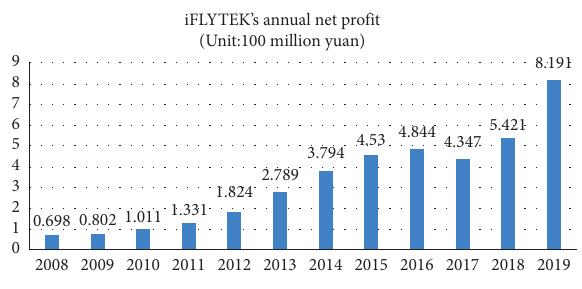
Figure 9: iFLYTEK’s annual net profit (the data in Figure 9 are compiled by the author according to iFLYTEK’s annual reports over the